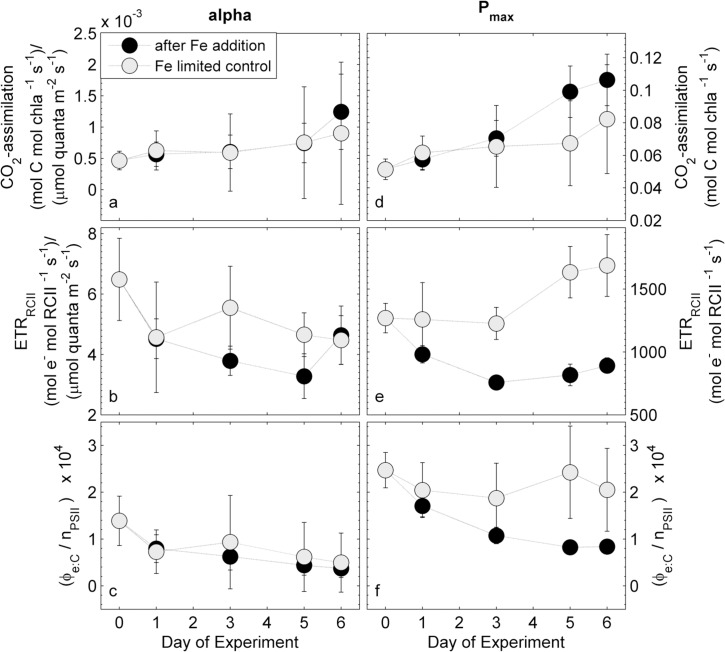
Time-course of α (a-c) and Pmax (d-f) of CO2-assimilation, ETRRCII and the derived conversion factor Φe:C/nPSII during the iron addition experiment.The conversion factor Φe:C/nPSII under light limiting conditions is derived from values in (a) and (b). Similarly, the conversion factor Φe:C/nPSII at light saturation is derived from the values in (d) and (e). The error in (a), (b), (c), and (d) is the 95% confidence interval of the parameter derived from the fit to data from three biological replicates, and the error in (c) and (f) is the propagated error from (a)/(b) and (d)/(e), respectively.